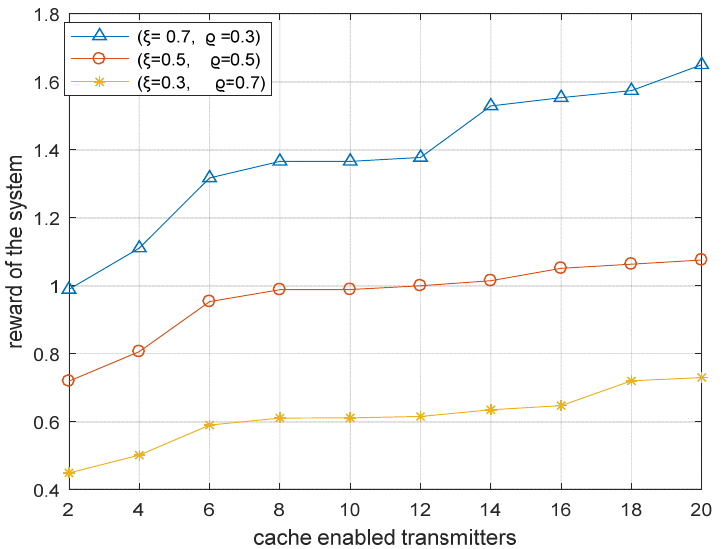
Figure 8. Cache hit ratio vs. cache size of incentivized D2D transmitters.